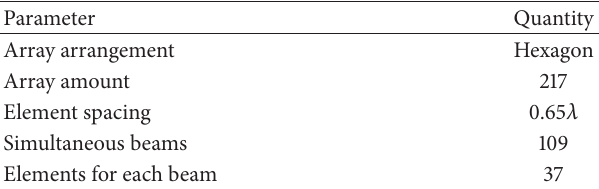
Table 3: Summary of the FAST-PAF configurations.